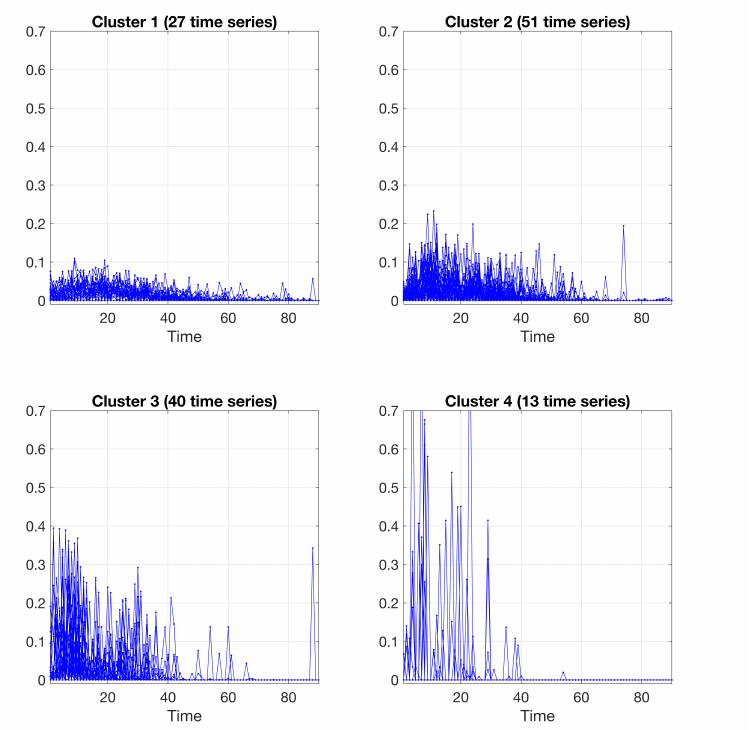
Figure 7. Clustering results obtained by the polynomial regression model, using a polynomial of order 4; 27 time series in cluster 1, 51 time series in cluster 2, 40 time series in cluster 3, and 13 time series in cluster